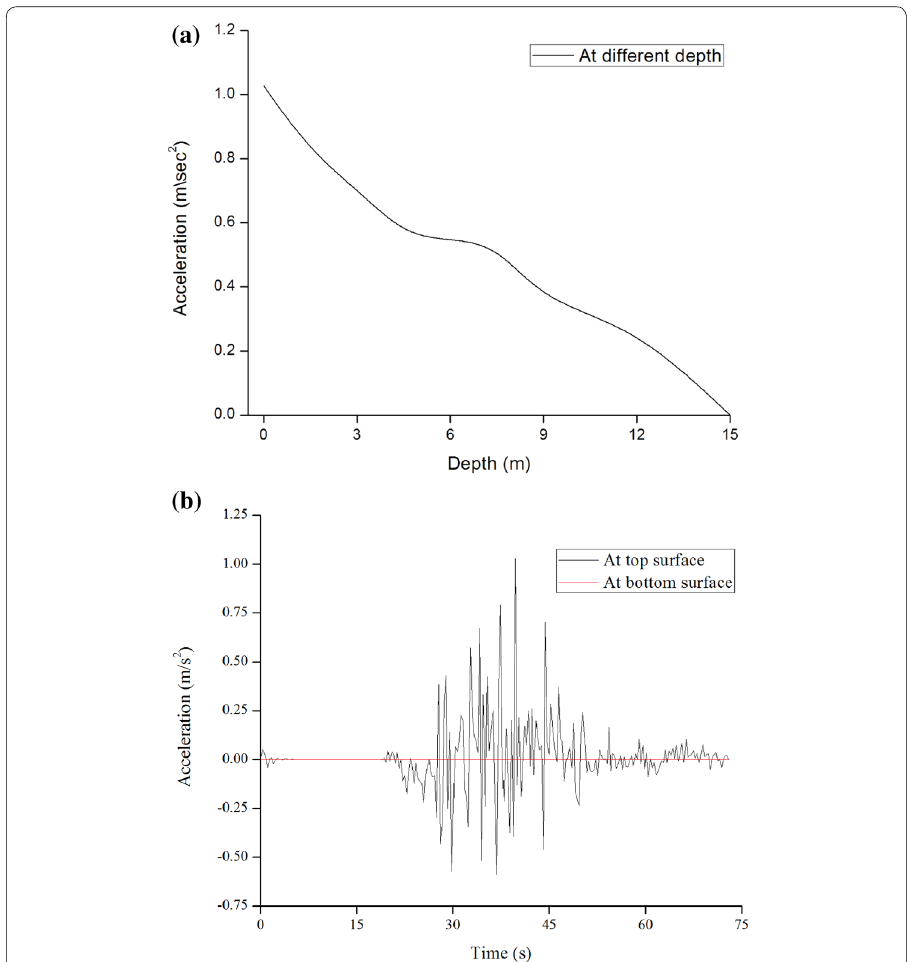
Fig. 14 Plot of acceleration vs depth a peak value at different depth, b at top and bottom